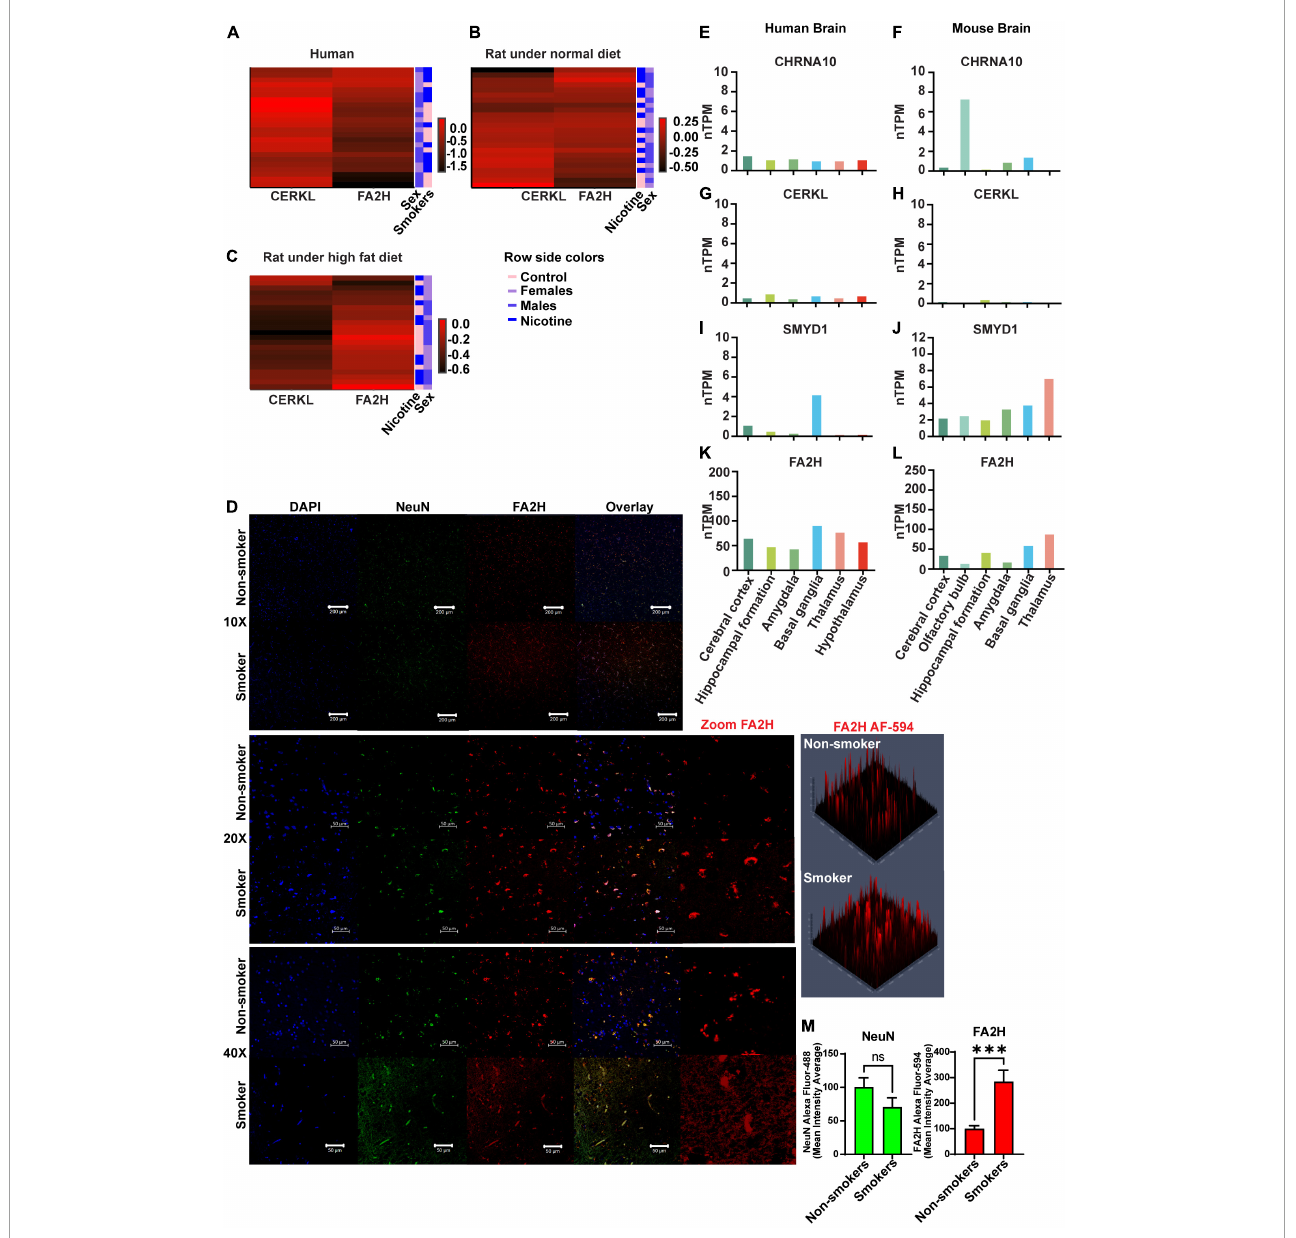
FIGURE4 Heatmap analysis and immunohistrochemistry (IHC) of FA2H in human brains. Heatmap represents gene expression changes of CERKL or FA2H genes in humans (A) or rats that received an RD (B) or an HFD (C) . In panel (D) , a representative image of protein expression of FA2H (red color) was analyzed by IHC and confocal microscopy. Basal levels of CHRNA10 (E,F) (https://www.proteinatlas.org/ENSG00000129749-CHRNA10/brain), CERKL (G,H) (https://www.proteinatlas.org/ENSG00000188452-CERKL/brain), SMYD1 (I,J) (https://www.proteinatlas.org/ENSG00000115593-SMYD1/brain), and FA2H (K,L) (https://www.proteinatlas.org/ENSG00000103089-FA2H/brain) in normalized levels of RNA (nTPM) are shown in human or mouse brain (Courtesy of Human Protein Atlas proteinatlas.org). Histograms of the quantitative analysis of the IHC for NeuN or FA2H are shown (M) . Each bar represents the mean ± SEM of 3 images per subject, ns, no significant; *** p < 0.001 ( t